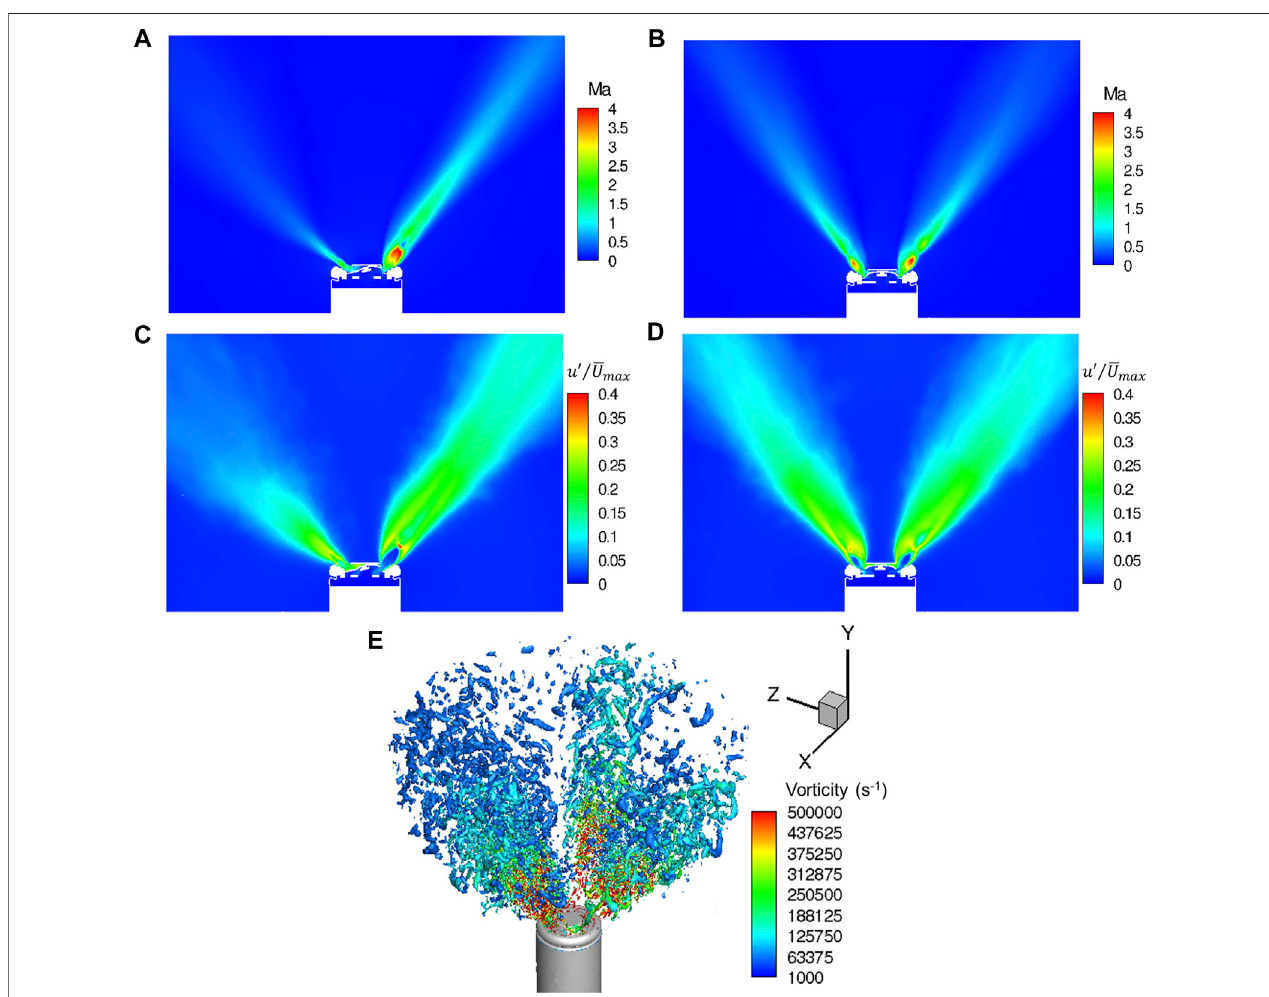
FIGURE 11 | SRS simulated mean velocity, represented by Mach number, at P 1 /P 2 (cid:1) 23.7 for the LG MJ1 cap in the x-normal (A) and z-normal (B) planes, normalized fl uctuating velocity magnitude in the x-normal (C) and z-normal planes (D) , and a 3-D isosurface taken at normalized Q-criterion (cid:1) 0.3 colored by vorticity magnitude which illustrates coherent turbulence structures in the jet fl ow (E)